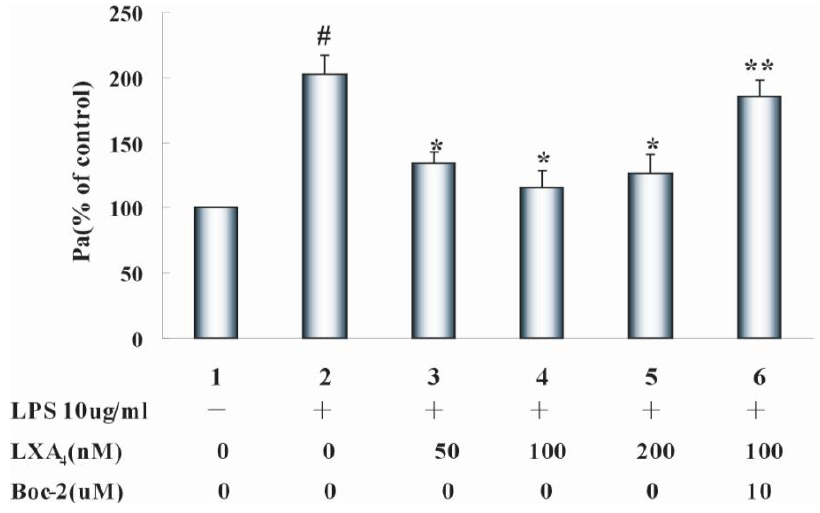
FIGURE 1. Effect of LXA on endothelial permeability in LPS-stimulated 4 HUVECs. LPS with or without LXA were administrated for 12 h in the upper 4 chamber. Boc-2 was applied 30 min prior to LXA . Pa value was applied to 4 indicate the endothelial permeability. Data are expressed as percentage of control cells; # p < 0.01 compared to control cells; * p < 0.05 compared to LPS- stimulated cells; ** p < 0.01 compared to LXA + LPS–treated cells. All 4 experiments were carried out in triplicate and for three independent times.